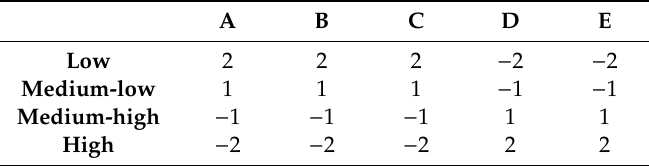
Table 2. Assigned values to four classes where are grouped the socio-demographic characteristics and ecosystem services supply at the neighborhood level. ( A ) Aging index; ( B ) Housing density; ( C ) Economically assisted citizens; ( D ) Provisioning and Regulating Services; ( E ) S-AQI index.